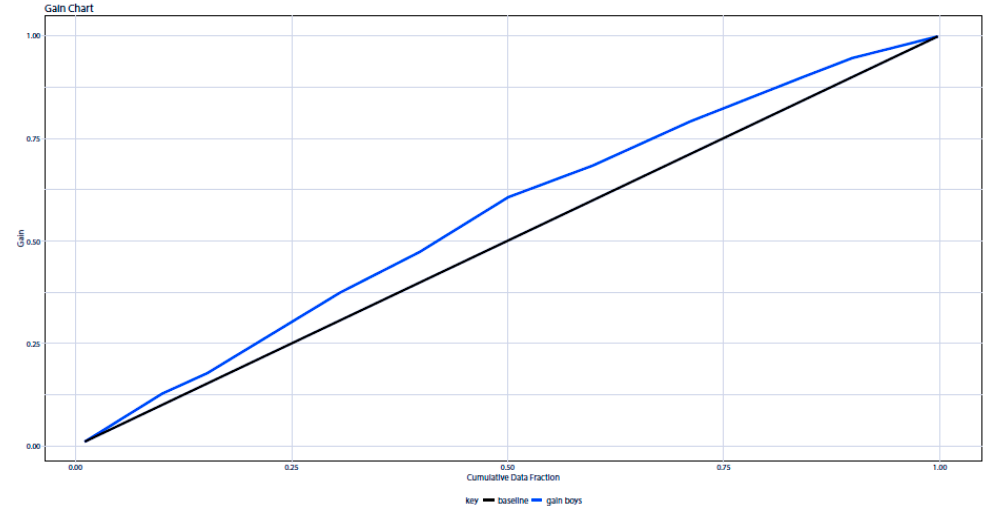
Figure 5. Lift chart for the mixed student sample.